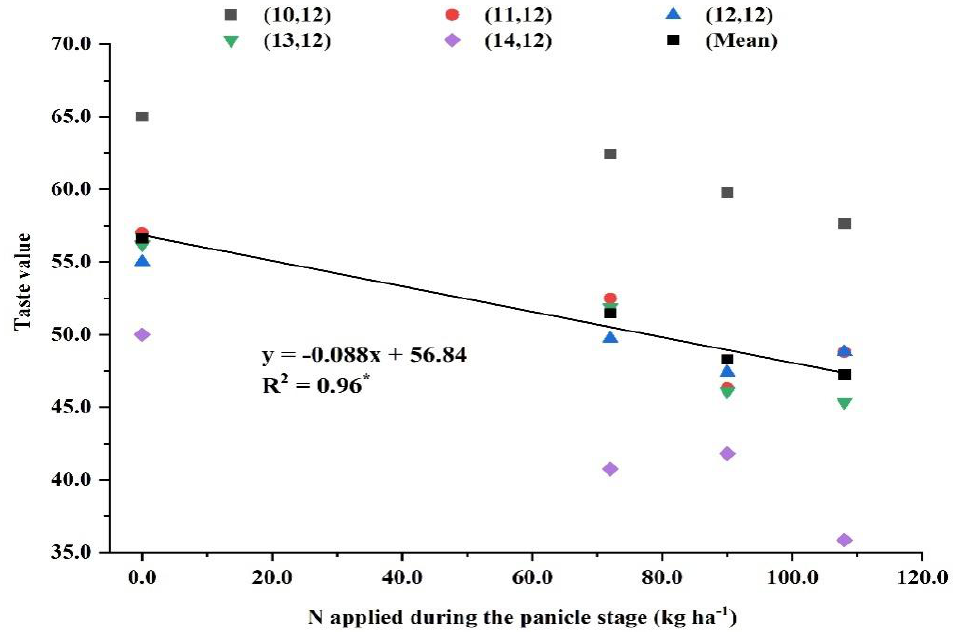
Figure 10. Correlation between taste value and N fertilizer application at different leaf ages during the panicle stage. The (10,12), etc., represent the patterns of different applications of N and K at the the panicle stage. The (10, 12), etc., represent the patterns of different applications of N and K at the panicle stage. * p < panicle stage. * p < 0.05.